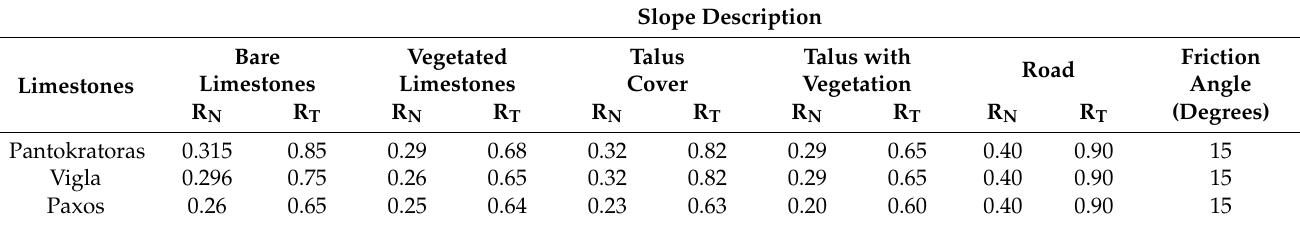
Table 3. Calibrated coefficients of restitution for each slope material. Slope Description